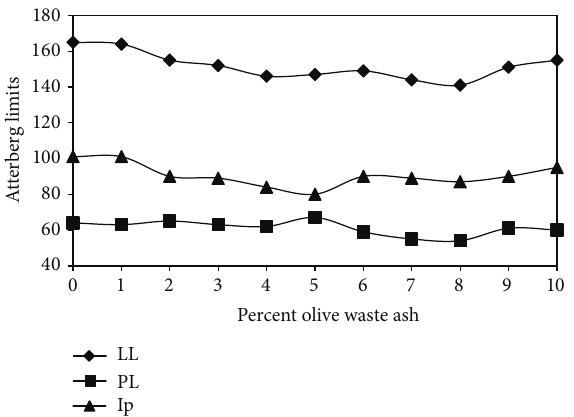
Figure 1: Effect of olive waste ash on the Atterberg